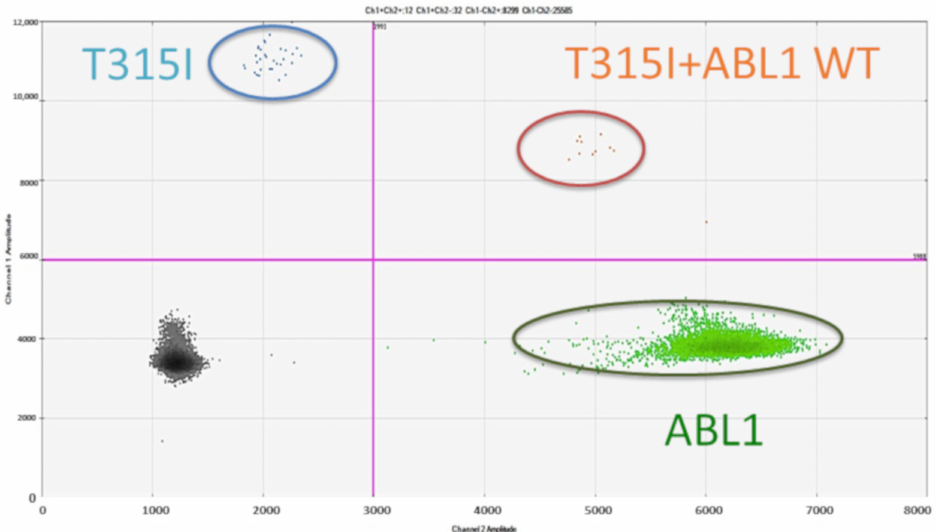
Figure 3. An example of application of dPCR for the detection of a mutation on genomic DNA. Here, a blue-labeled probe is designed to detect the T315I mutation and a green labeled probe is designed to detect unmutated ABL1 . The quantitation of variant allele frequency (VAF) is obtained by the ratio between T315I and ABL1